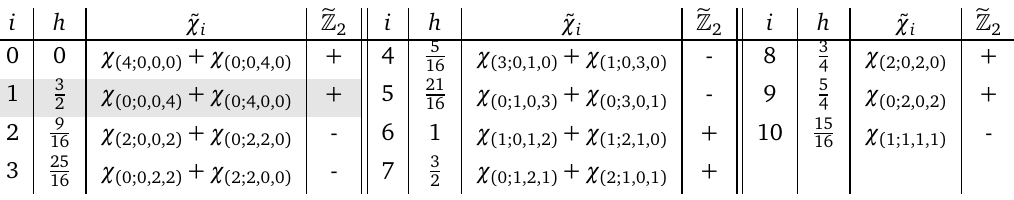
2 , 2 + (cid:12) 2 + (cid:12) 2 + (cid:12) 2 + (cid:12) 2 + (cid:12) (cid:12) (cid:12) (cid:12) (cid:12) (cid:12) (cid:12) (cid:12) (cid:12) (cid:12) (cid:12) (cid:12) (cid:12) χ + χ χ + χ χ + χ χ + χ χ + χ = (cid:12) (cid:12) χ + χ Z NS (cid:12) (cid:12) (cid:12) (cid:12) (cid:12) (cid:12) (cid:12) (cid:12) (cid:12) (cid:12) (cid:12) (cid:12) (cid:12) (cid:12) (cid:12) (cid:12) (cid:12) (cid:12) (cid:12) (cid:12) (cid:12) (cid:12) (cid:12) (cid:12) 16 17 13 14 12 15 4 5 1 2 0 3 F (cid:12) (cid:12) (cid:12) (cid:12) (cid:12) (cid:112) (cid:12) (cid:12) (cid:12) (cid:12) (cid:12) 2 + (cid:12) 2 + (cid:12) 2 + (cid:12) 2 + (cid:12) 2 = (cid:12) (cid:12) χ + χ Z R . 2 χ (cid:12) (cid:12) χ 9 + χ 11 (cid:12) (cid:12) χ 18 + χ 20 (cid:12) (cid:12) 2 χ 7 (cid:12) (cid:12) (cid:12) 6 8 19 F / (cid:90) Table 10: SU ( 4 ) : primaries labeled by i are characterized by weights h . Their characters 4 2 χ are expressed by the characters of SU ( 4 ) WZW model. We highlight the primary related to (cid:101) i 4 the (cid:101) (cid:90) 2